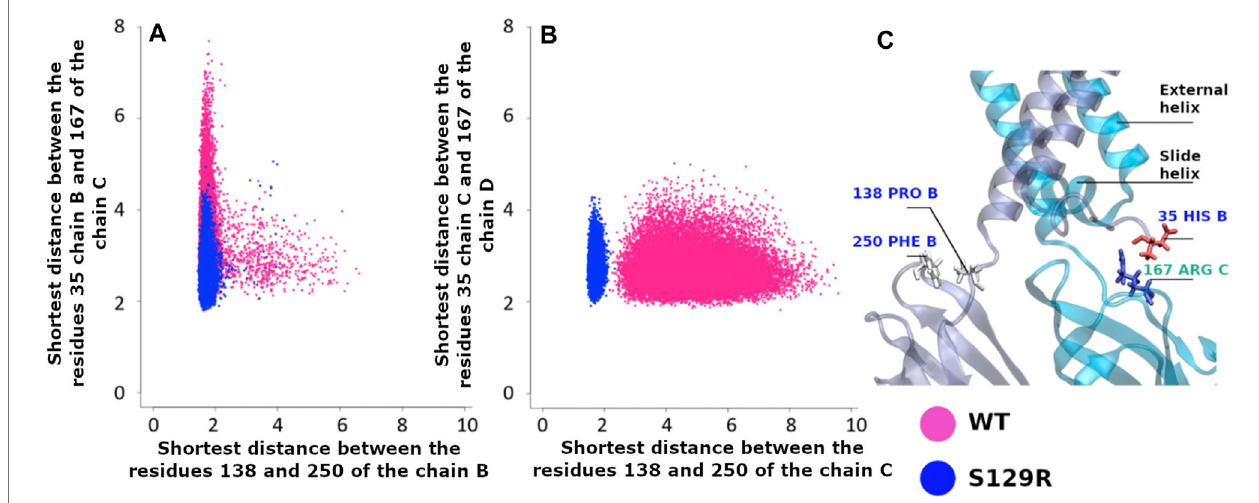
FIGURE 6 | Interaction between the cytoplasmic and the membrane interface. Pink points are for KirBac3.1 WT, blue points for the S129R mutant (A) Shortest distancebetweentheslide-helix(residueAsp35ChainBandtheCD-loop(residueArg167ChainC)vs.theshortestdistancebetweenthelinker(residuePro138ChainB) and the G-Loop (residue Phe250 Chain B); (B) Shortest distance between the slide-helix (residue Asp35 Chain C) and the CD-loop (residue Arg167 Chain D) vs. the distances between the linker (residue Pro138 Chain C) and the G-Loop (residue Phe250 Chain C); (C) Location of the